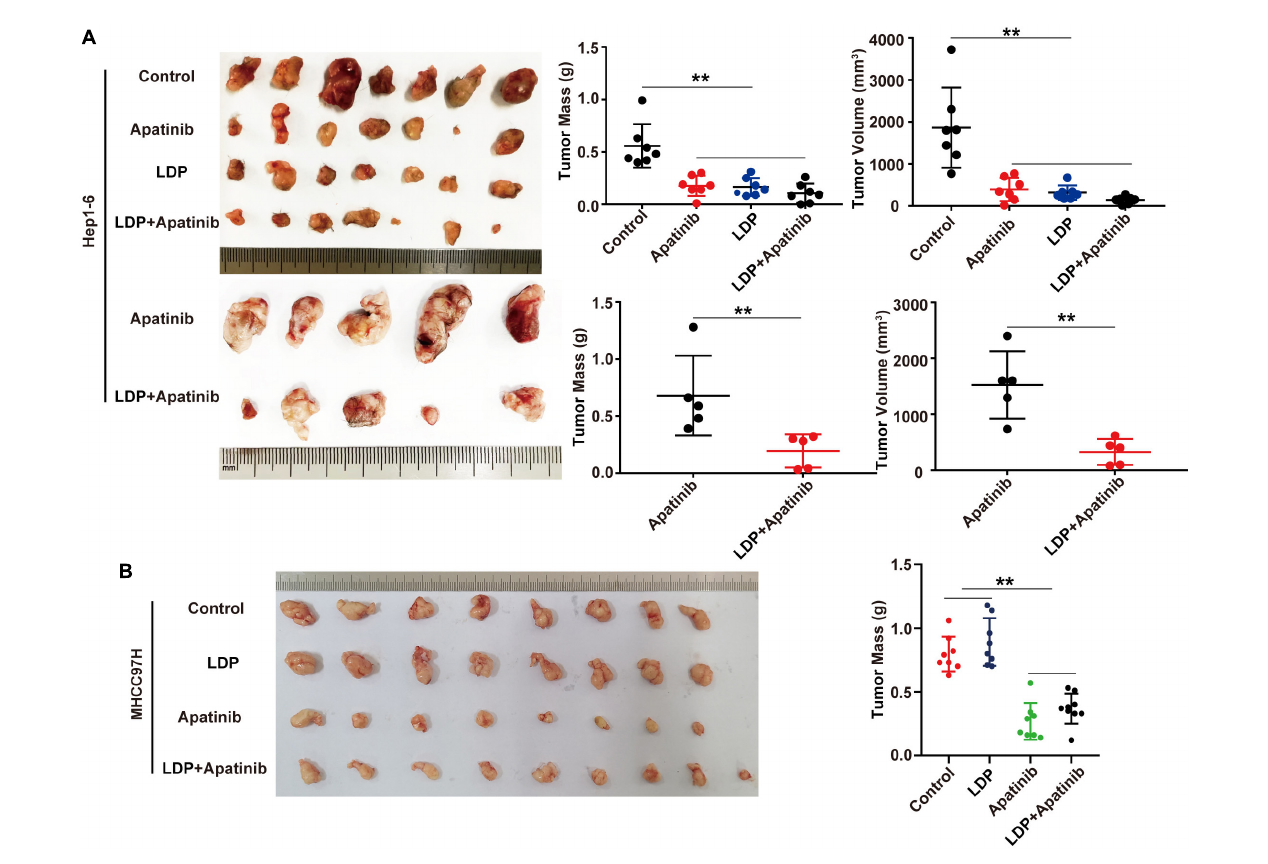
FIGURE6 LDP enhances the anticancer effect of apatinib in immunogenic mice, but does not increase the anticancer effect of immunodeficient mice. (A) Subcutaneous tumors of C57BL/6 mice and volume and mass values at specific time points ( n = 5 or 7). (B) Subcutaneous tumors of BALB/C mice and volume and mass values at specific time points ( n = 8 or 9). ** p <